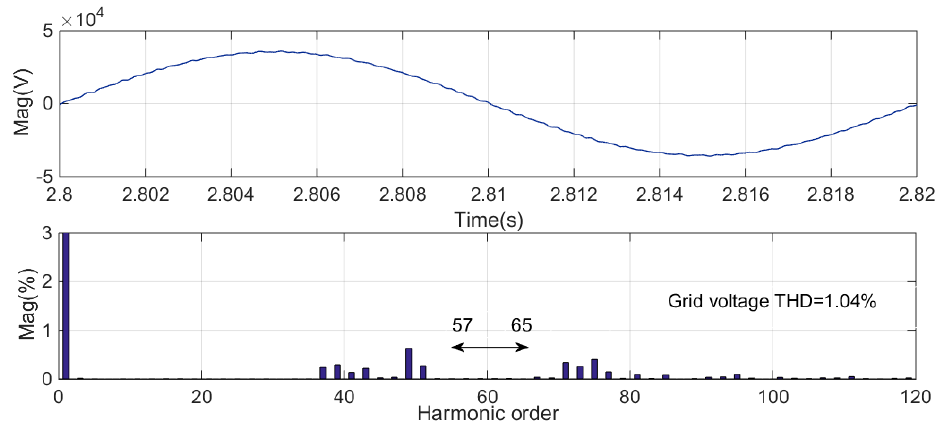
Figure 29. Waveform and FFT analysis of grid voltage with SHE-PWM algorithm.